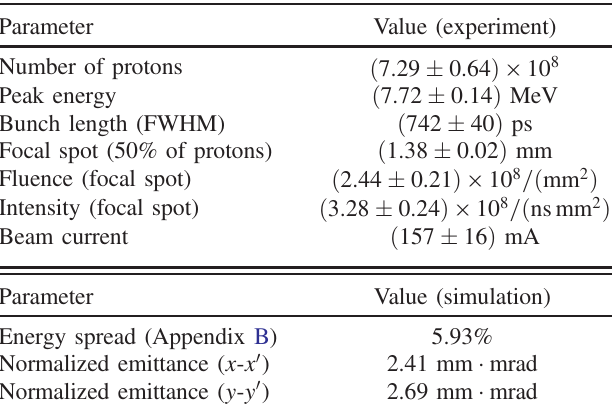
TABLE II. Most important parameters of the longitudinally and transversely focused proton bunch at the end of the LIGHT beamline 5.7 m to the TNSA target.